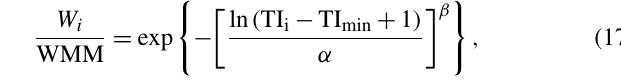
With the rainfall P and the evaporation E , the surface runoff Q S and the groundwater runoff Q G are